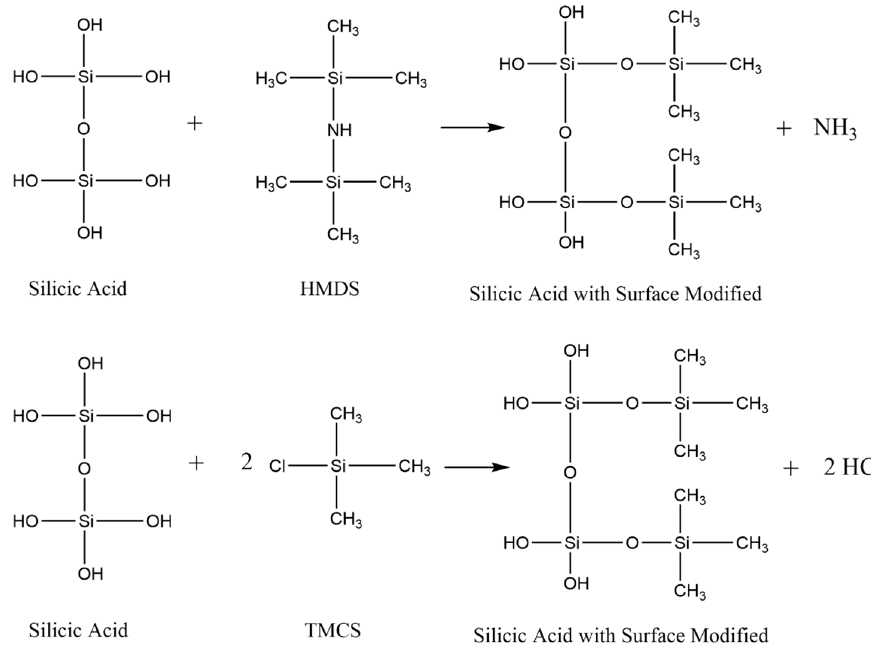
Figure 11. Formation reaction using HMDS and TMCS [28].